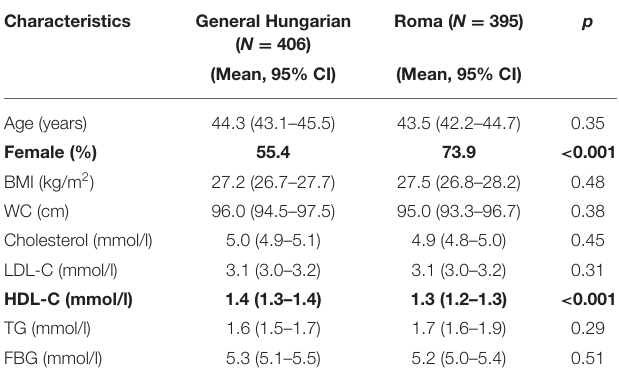
TABLE 1 | Characteristics of the study participants selected from the database of the complex survey. Characteristics